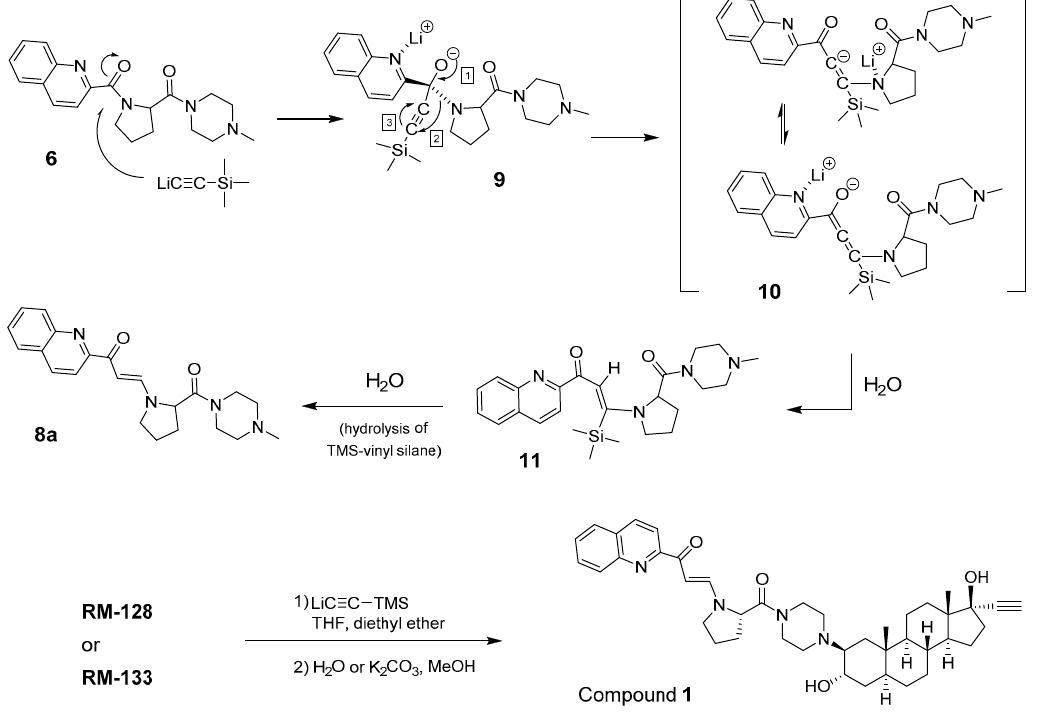
Figure 5. Proposed mechanism of reaction leading to β -enaminones 8a and 1 .